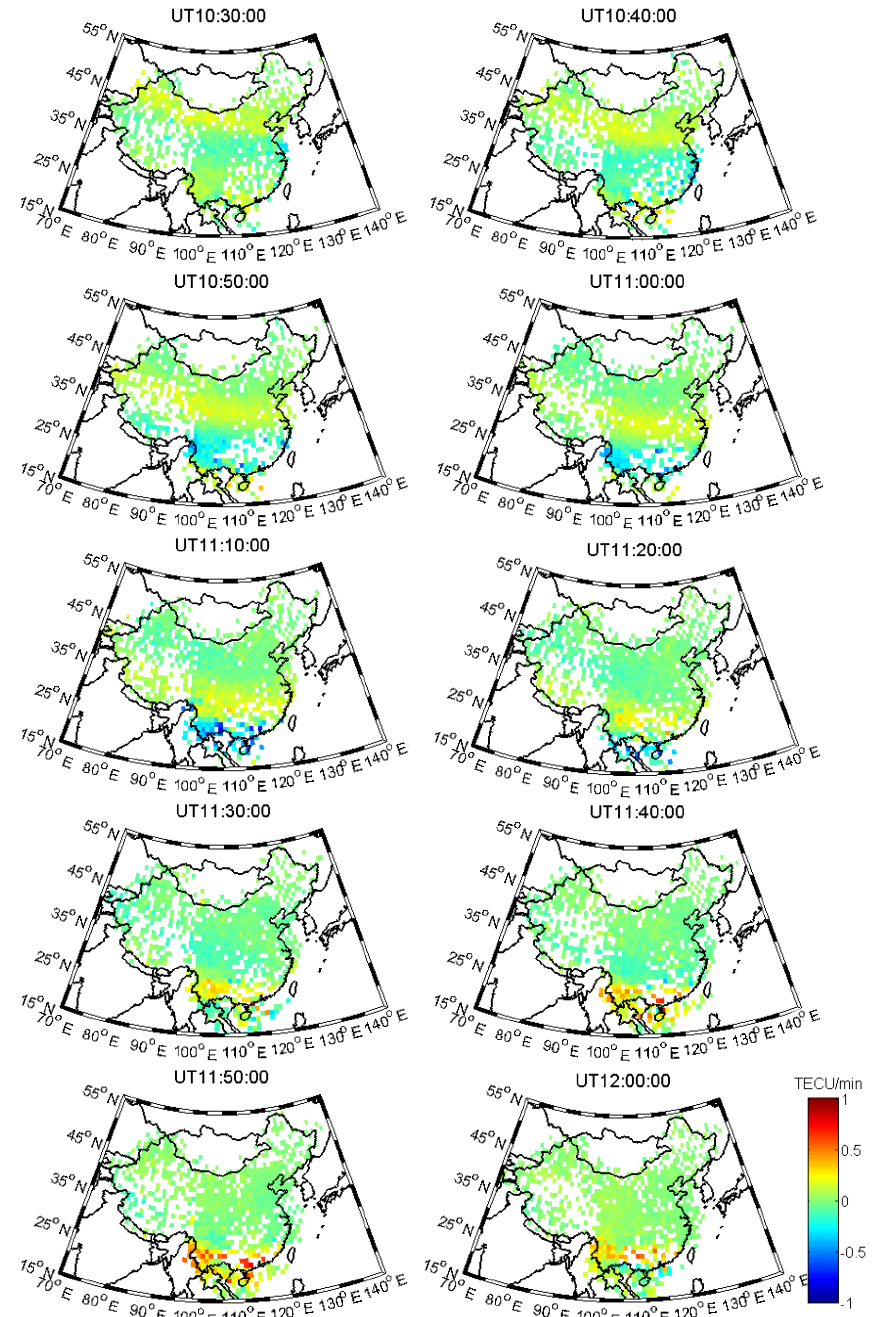
Figure 3. Snapshots of DROVT maps at various time epochs from 10:30 to 12:00UT on 17 March